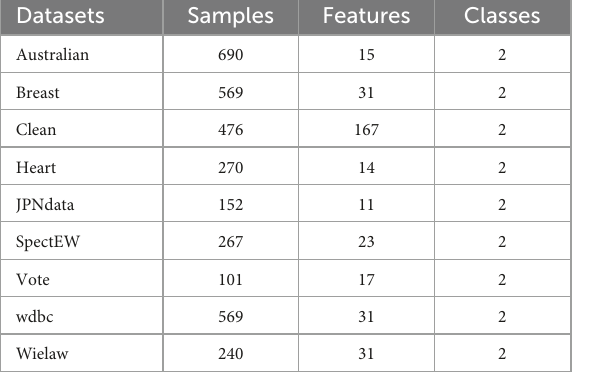
TABLE 10 A detailed description of the public dataset.